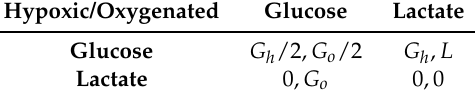
Table 1. Payoff matrix for the cancer game in [10], where L > G o /2. This 2 × 2 game represents the tumor metabolic symbiosis rewards (ATP generation). The row agent represents hypoxic cells, and the column one represents oxygenated cell energy generation values based on their collective actions. Specifically, oxygenated cells can use both glucose and lactate for energy generation, whereas the hypoxic cells can use only glucose. Empirical data as discussed in [10] suggests that L > Go /2. Hypoxic/Oxygenated Glucose Lactate Glucose G h /2, G o /2 G h , L Lactate 0, G o